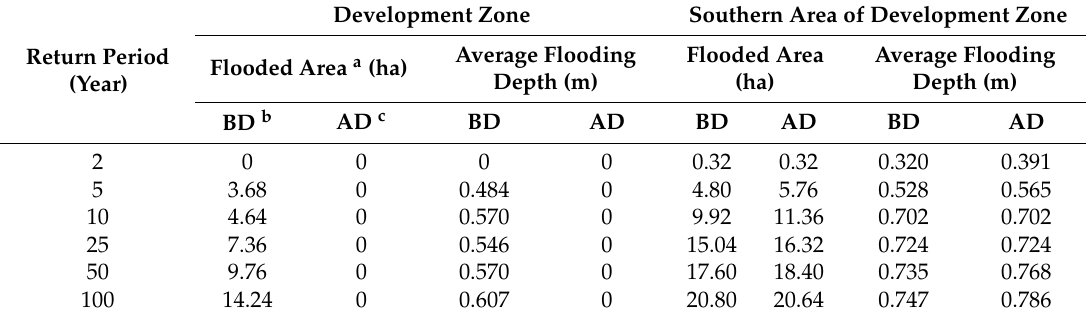
Table 4. Flooded area and the average flooding depths of various return periods before and after land